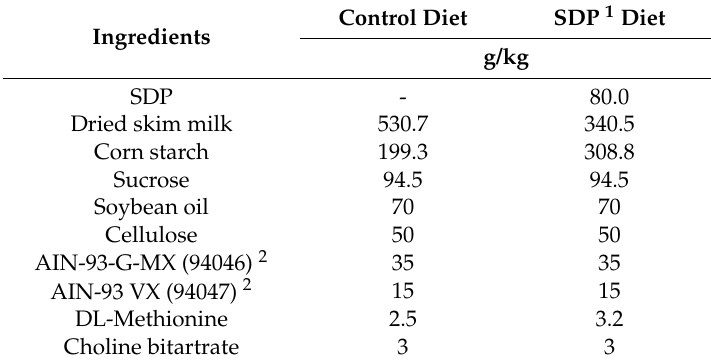
Table 1. Composition of experimental